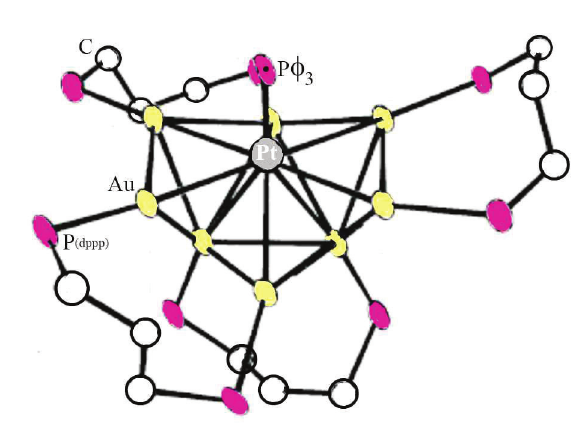
)PtAu (µ-η 2 -dppp) 3 8